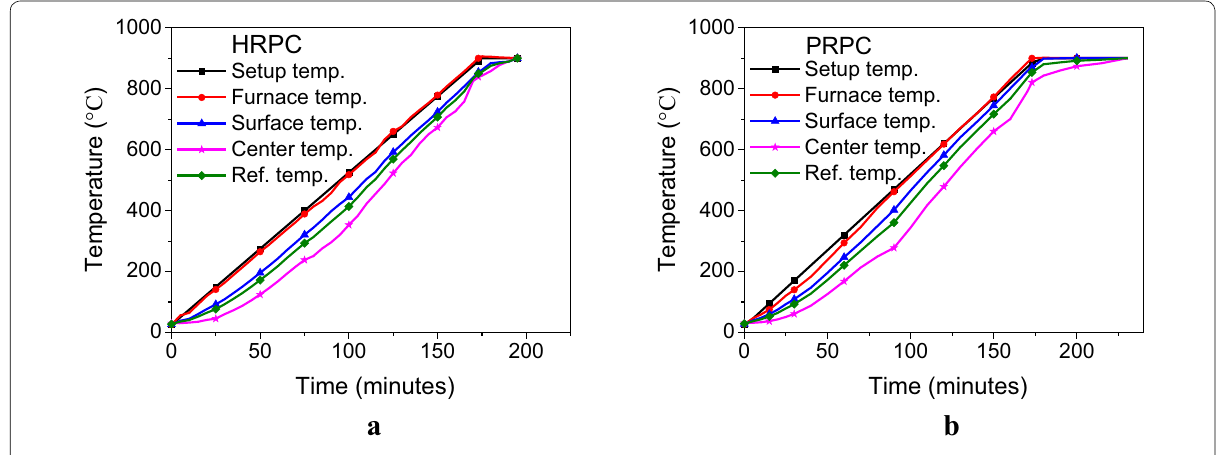
Fig. 4 Time-temperature curves for FTS and TS of a HRPC and b PRPC specimens.